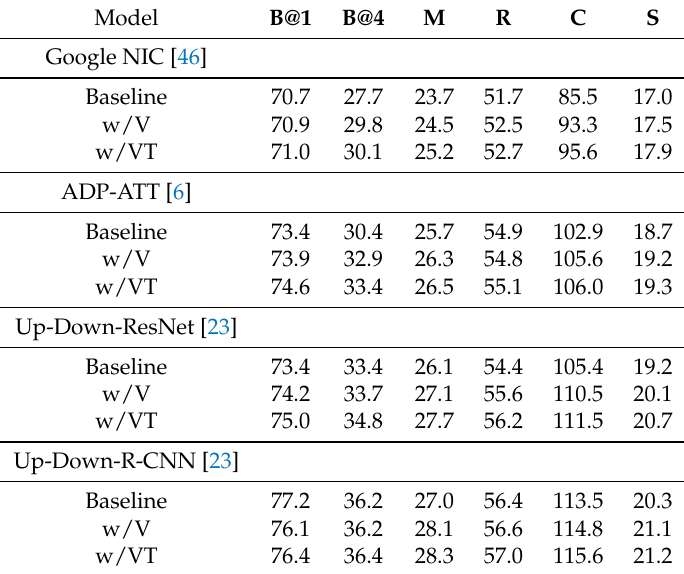
Table 2. Experiment results when we replace the information sources by the visual encoder result “V” or the added sum result “VT”.